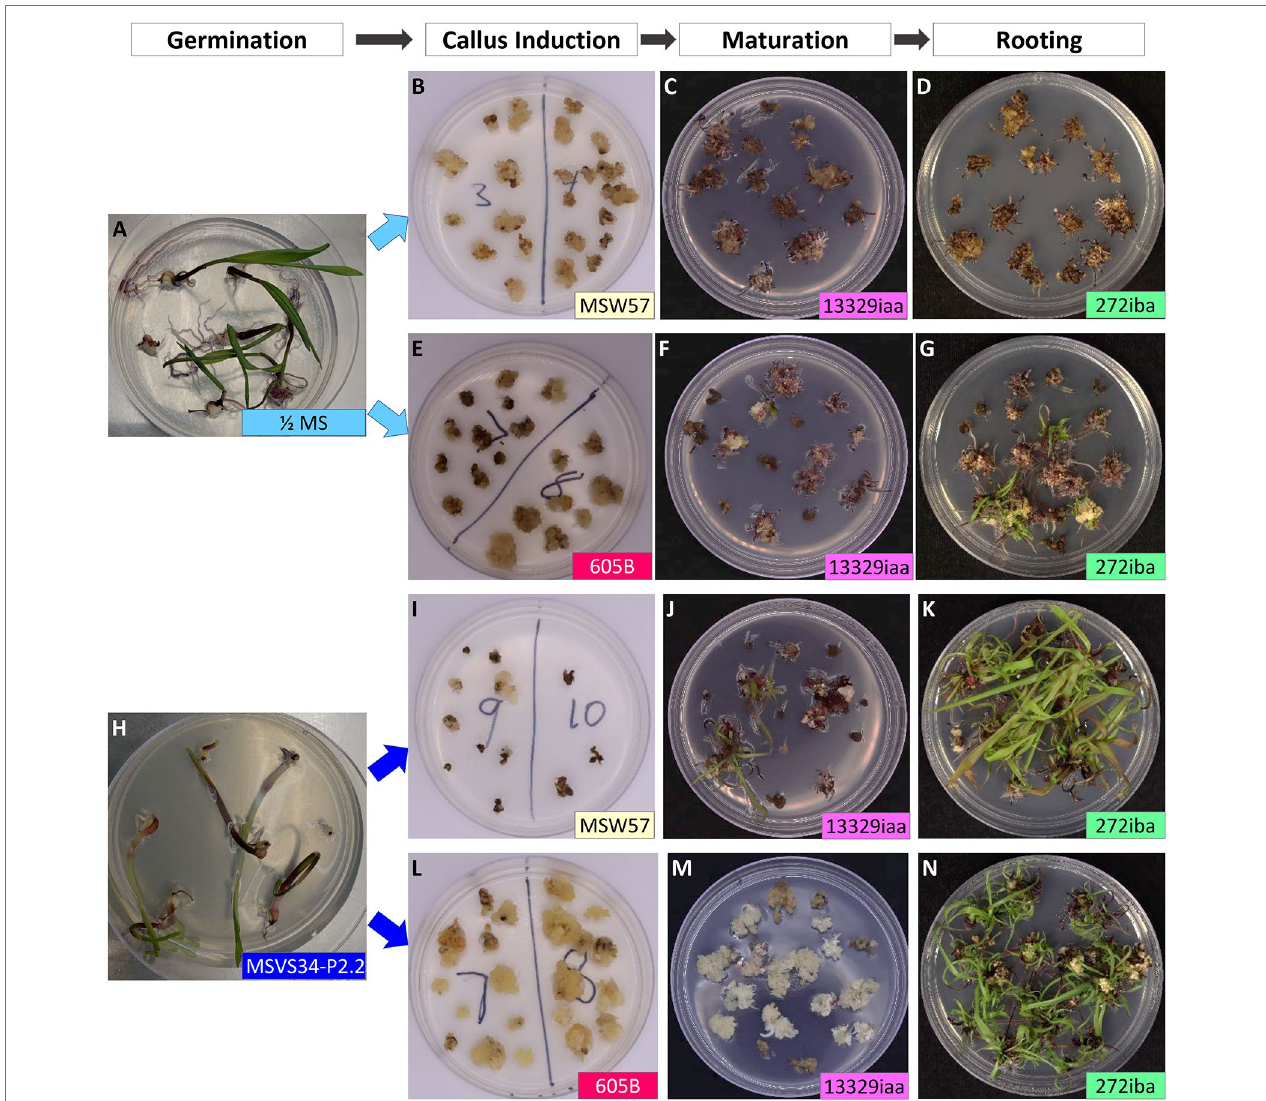
FIGURE 3 | Effects of germination and callus induction media on teosinte callus induction and regeneration. Disinfected, “naked” teosinte seeds germinated on ½ MS medium (A) or MSVS34-P2.2 medium (H) ; (B–D) leaf pieces from ½ MS germinated seedlings were cultured on callus induction medium (MSW57), maturation medium (13329iaa), and rooting medium (272iba); (E–G) leaf pieces from ½ MS germinated seedlings were cultured on callus induction medium (605B), maturation medium (13329iaa), and rooting medium (272iba); (I–K) leaf pieces from MSVS34-P2.2 germinated seedlings were cultured on callus induction medium (MSW57), maturation medium (13329iaa), and rooting medium (272iba); (L–N) leaf pieces from MSVS34-P2.2 germinated seedlings were cultured on callus induction medium (605B), maturation medium (13329iaa), and rooting medium (272iba). Approximate ages of the plant materials were: under the labels of Germination (A,H) , 21 days after sowing; Callus Induction (B,E,I,L) , 43 days after callus induction; Maturation (C,F,J,M) , 21 days after placing on Maturation medium; and Rooting (D,G,K,N) , 12 days after placing on rooting